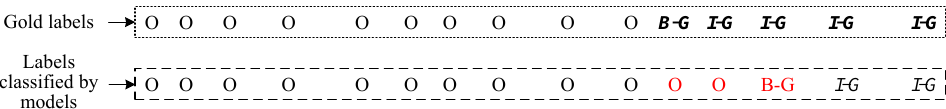
Figure 1. An example of sequence labeling-based NER. The “ KC and the Sunshine Band ” (in blue font) is a pre-defined Group entity, and its gold BIO label sequence is { B-G,I-G,I-G,I-G,I-G }. However, the sequence labeling-based NER model actually tags the “ KC ” with the O label, resulting in cascading label misclassifications, i.e., the O label for “ and ”, the B-G label for “ the ”, as the labels in red